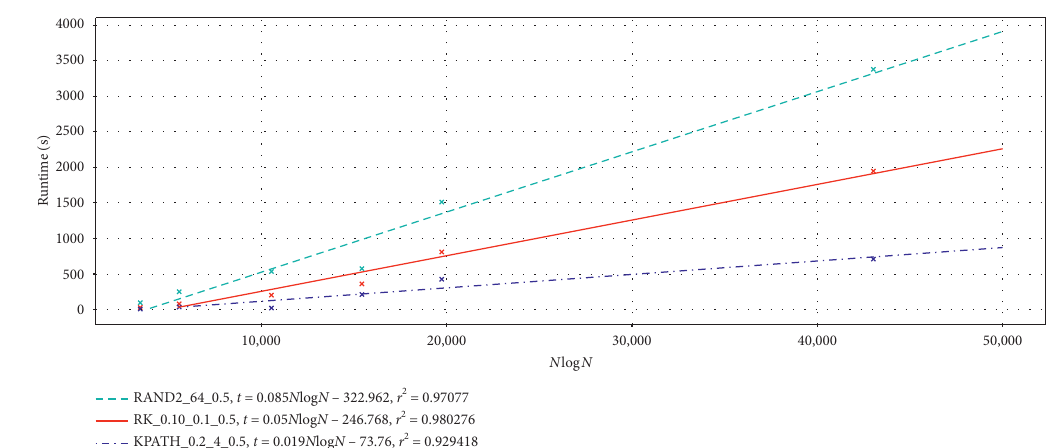
Figure 10: Runtime regrading different approximation methods; x -axis is N ∗ log N , where N is the size of the network.